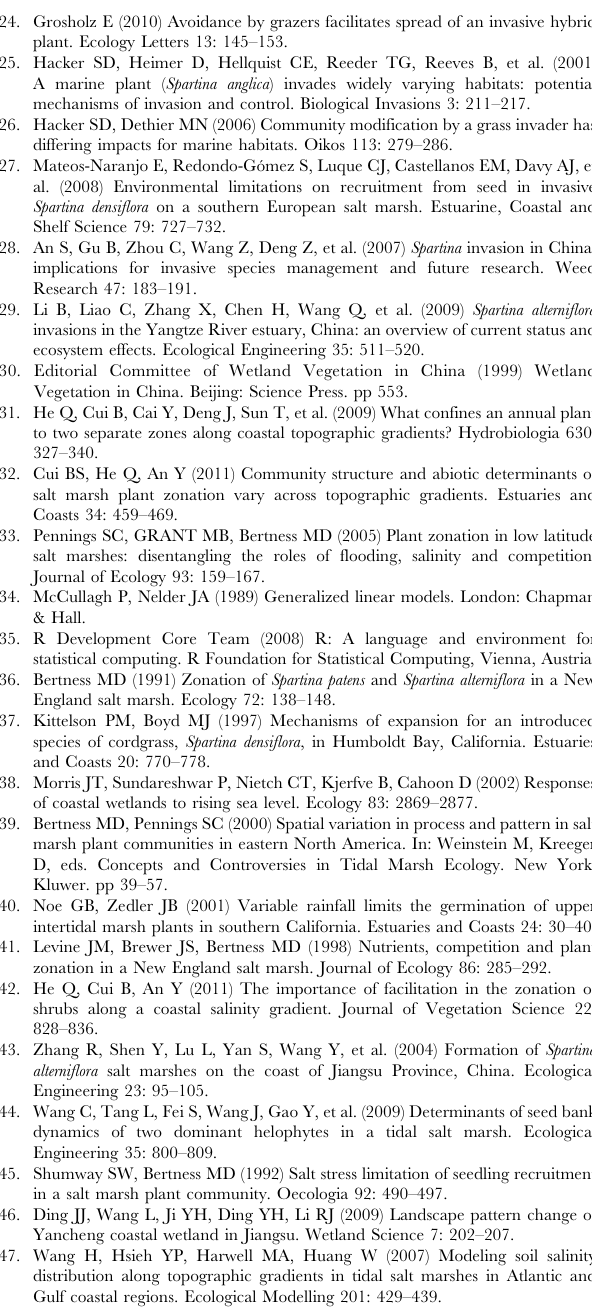
Table S1 Cordgrass performances (means 6 1SE) in different zones at the salt marsh site in